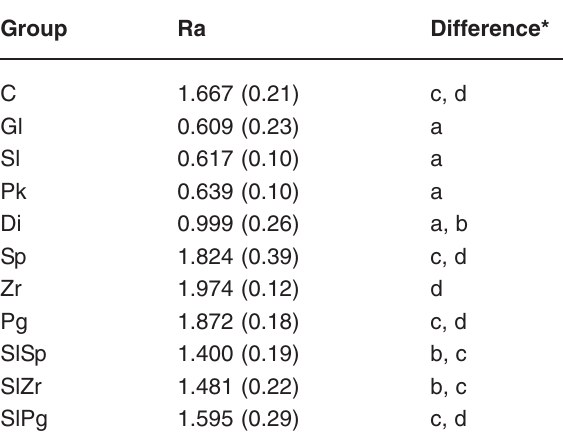
Table 2- Mean (SD) of surface roughness and differences between groups for Vita VMK 95 porcelain